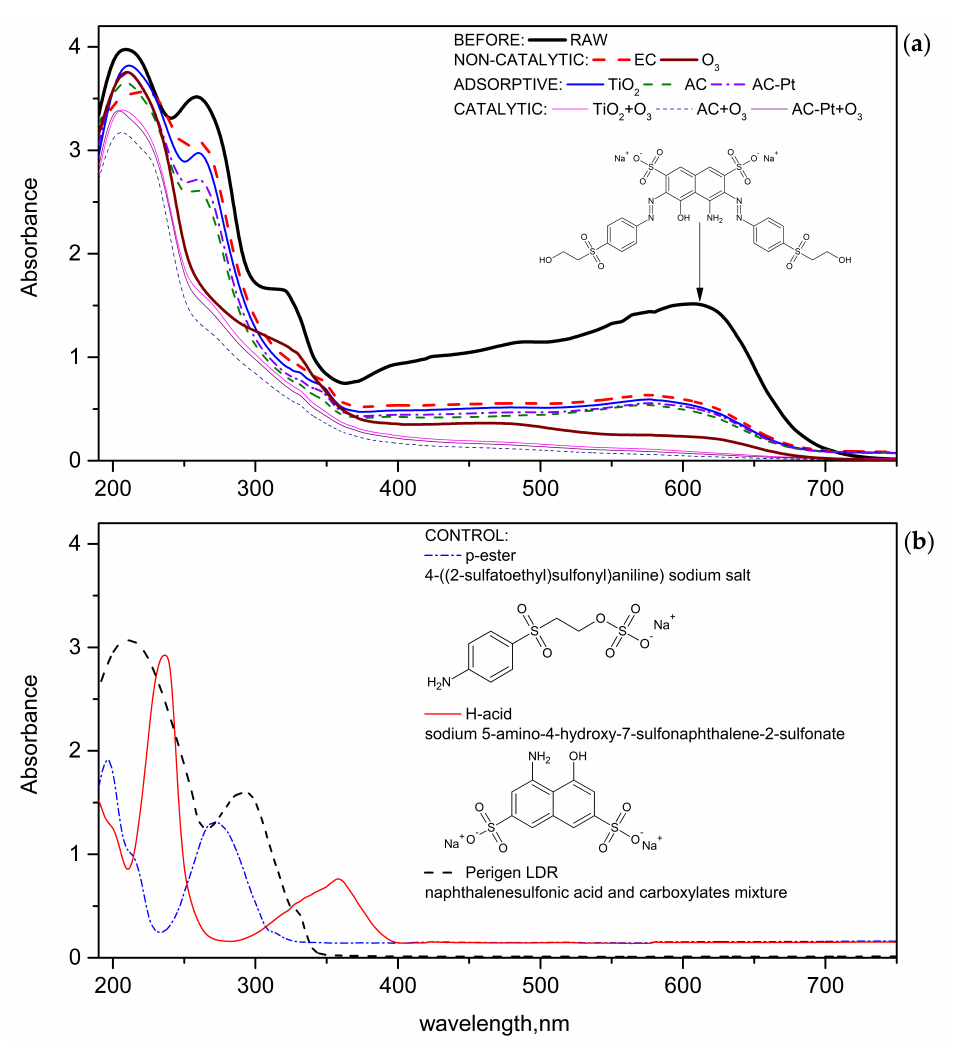
Figure 3. The UV–VIS spectra of the wastewater before and after treatment ( a ) and the control, model compounds ( b